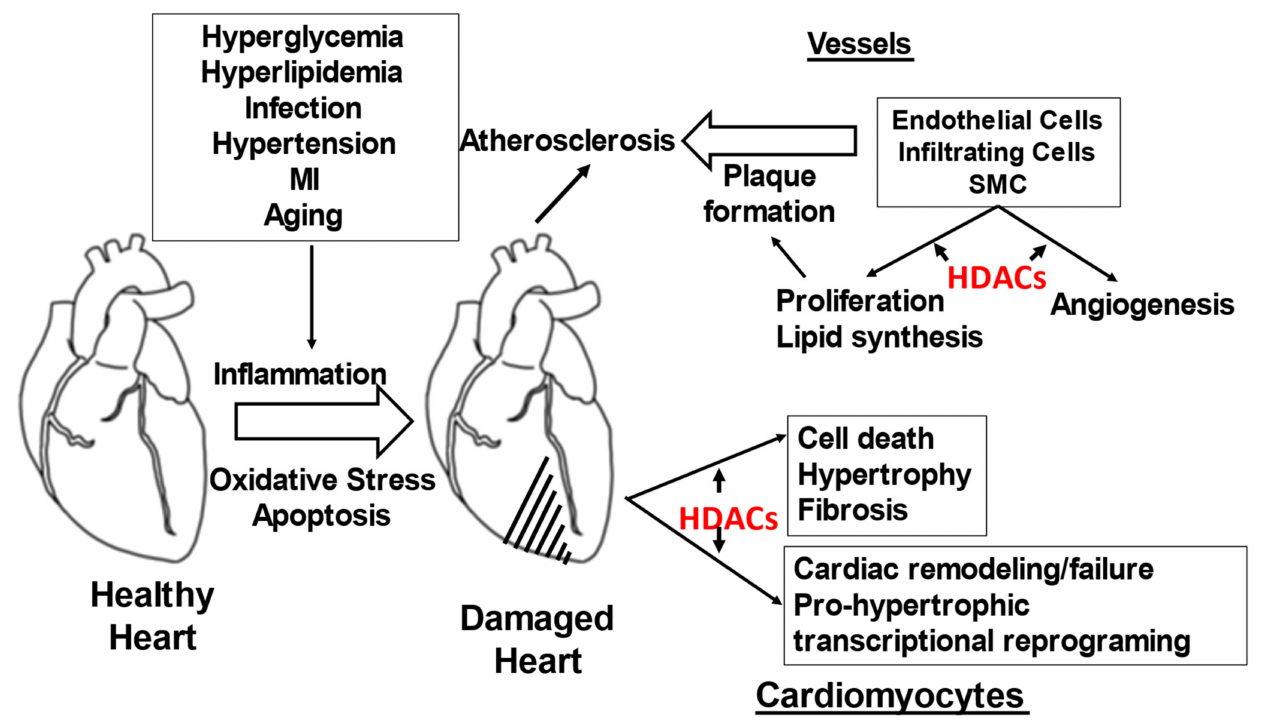
Figure 3. Role of HDACs in various attributes of CVDs